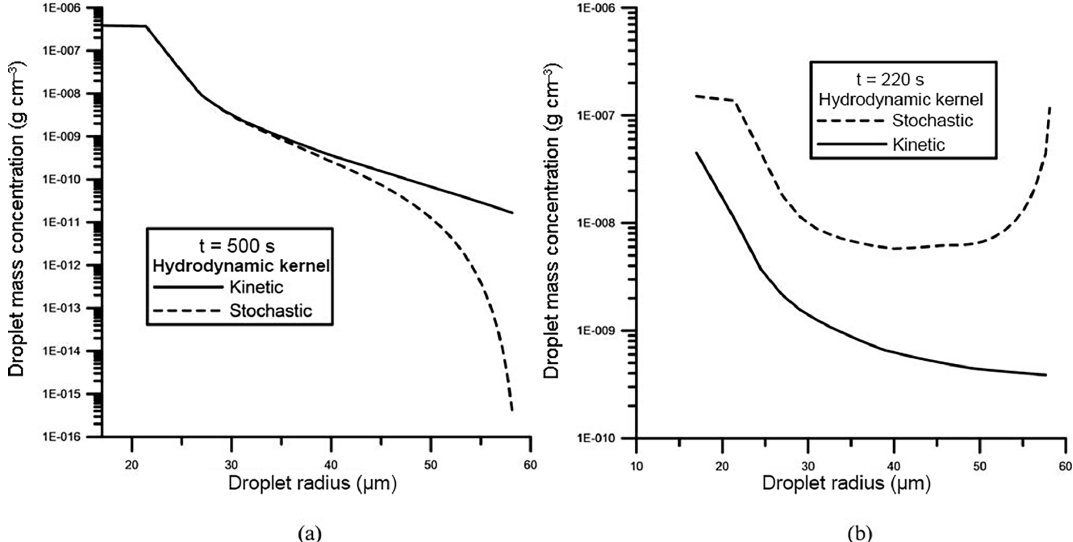
Figure 9. Comparison of the size distributions obtained from the stochastic master equation (dashed lines) with that to the KCE (solid lines) at t = 500s in (a) and t = 2200s in (b) for the hydrodynamic kernel. The initial distribution was bidisperse with 20 droplets of 17µm in radius and 10 droplets of 21.4µm in a volume of 1cm 3